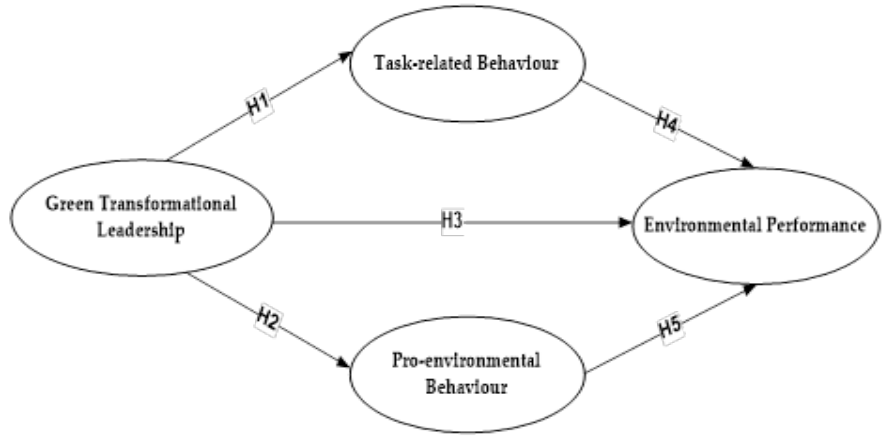
Figure 1. Theoretical model of the study.